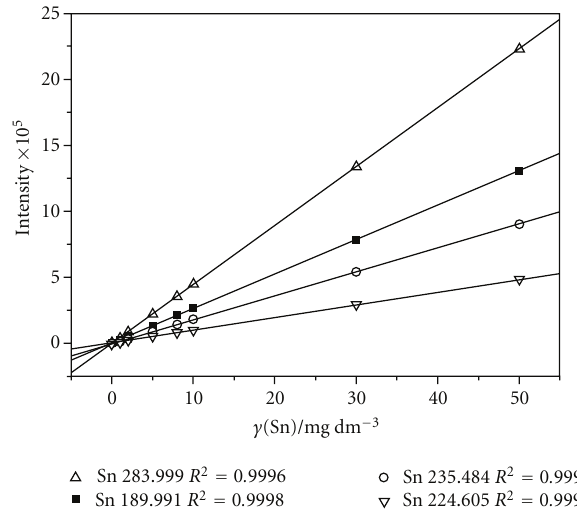
Figure 3: Calibration curves (HG-ICP-OES) in conventional mode.